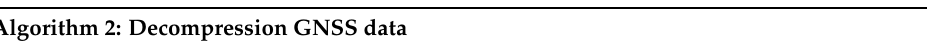
Algorithm 2: Decompression GNSS